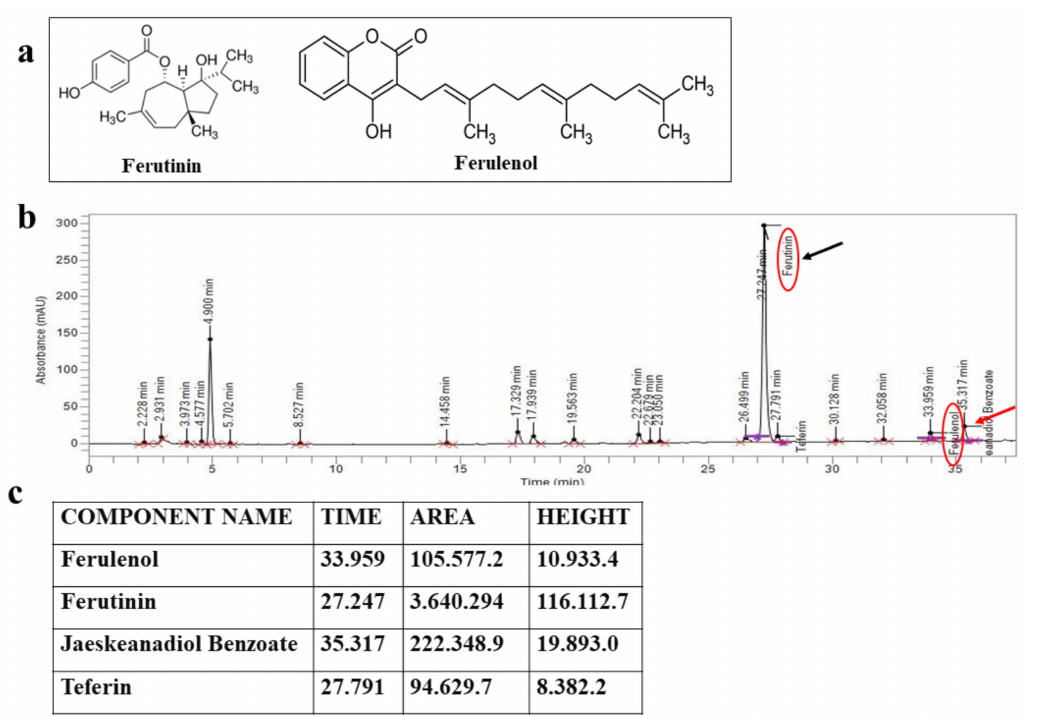
Figure 1. In panel ( a ) the chemical structures of ferutinin and ferulenol are represented; in panel ( b ) HPLC spectrum of FER-E, in which ferutinin and ferulenol are present, is shown. In panel ( c ) HPLC analysis values are